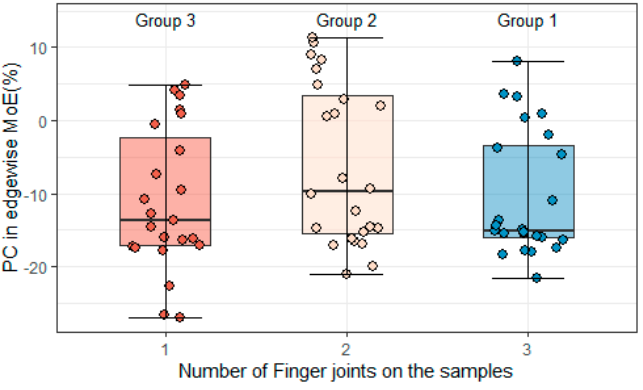
Figure 9. Percentage changes (PCs) in static edgewise MoE values.